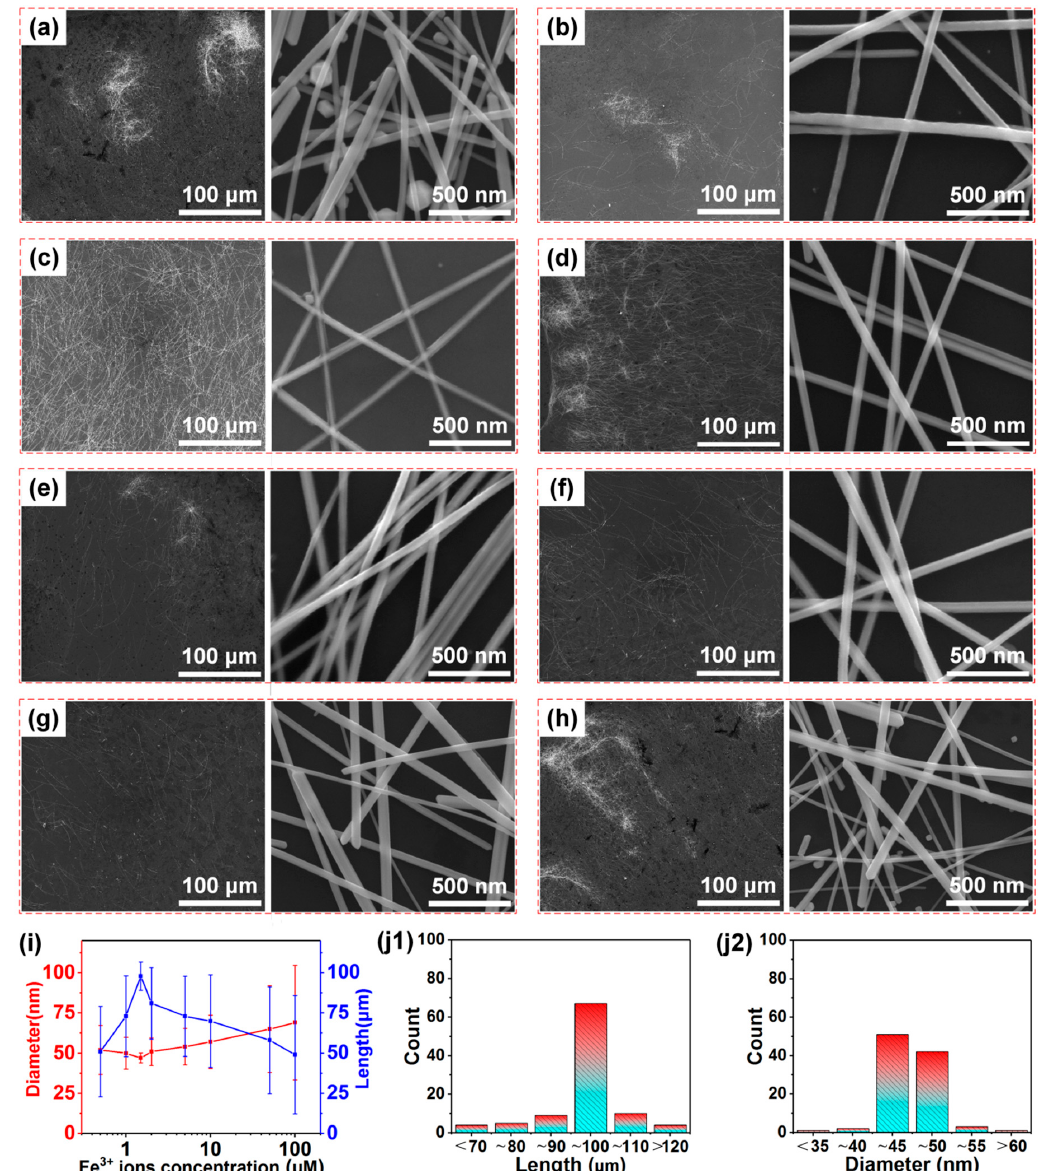
Figure 4. SEM images of products synthesized with 600 µM of NaCl, 100 µM of NaBr and different additions of Fe(NO 3 ) 3 . The amount of Fe(NO 3 ) 3 is ( a ) 0.5 µM, ( b ) 1 µM, ( c ) 1.5 µM, ( d ) 2 µM, ( e ) 5 µM, ( f ) 10 µM, ( g ) 50 µM, and ( h ) 100 µM, respectively. Changes in AgNW diameter and length with Fe 3+ ion concentration are summarized in ( i ). The histograms of AgNW length and diameter are, respectively, shown in ( j1 ) and ( j2 ) at 1.5 µM Fe 3+ concentration.